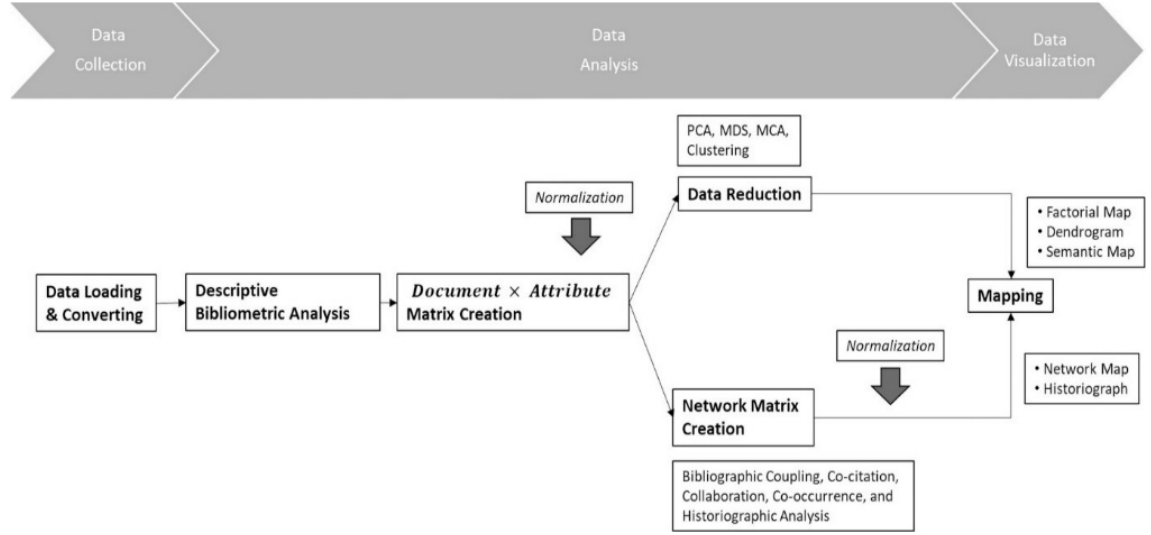
Figure 1. Bibliometrix and recommended science mapping